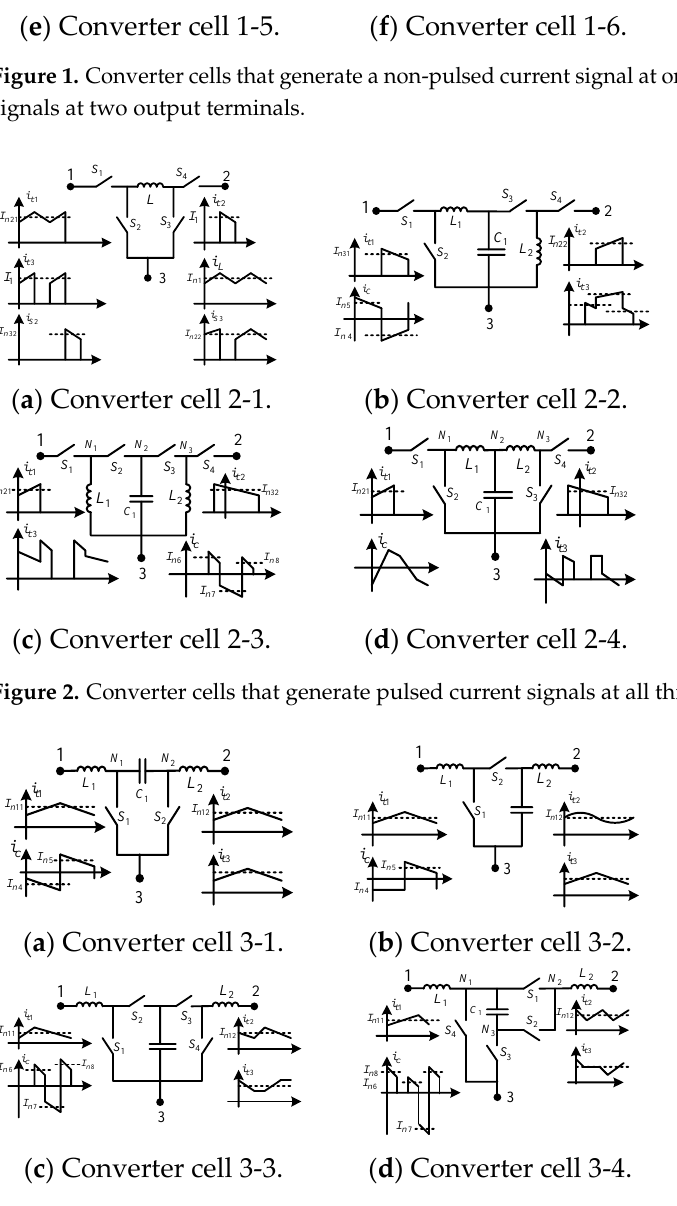
Figure 3. Converter cells that generate non-pulsed current signals at all three terminals .